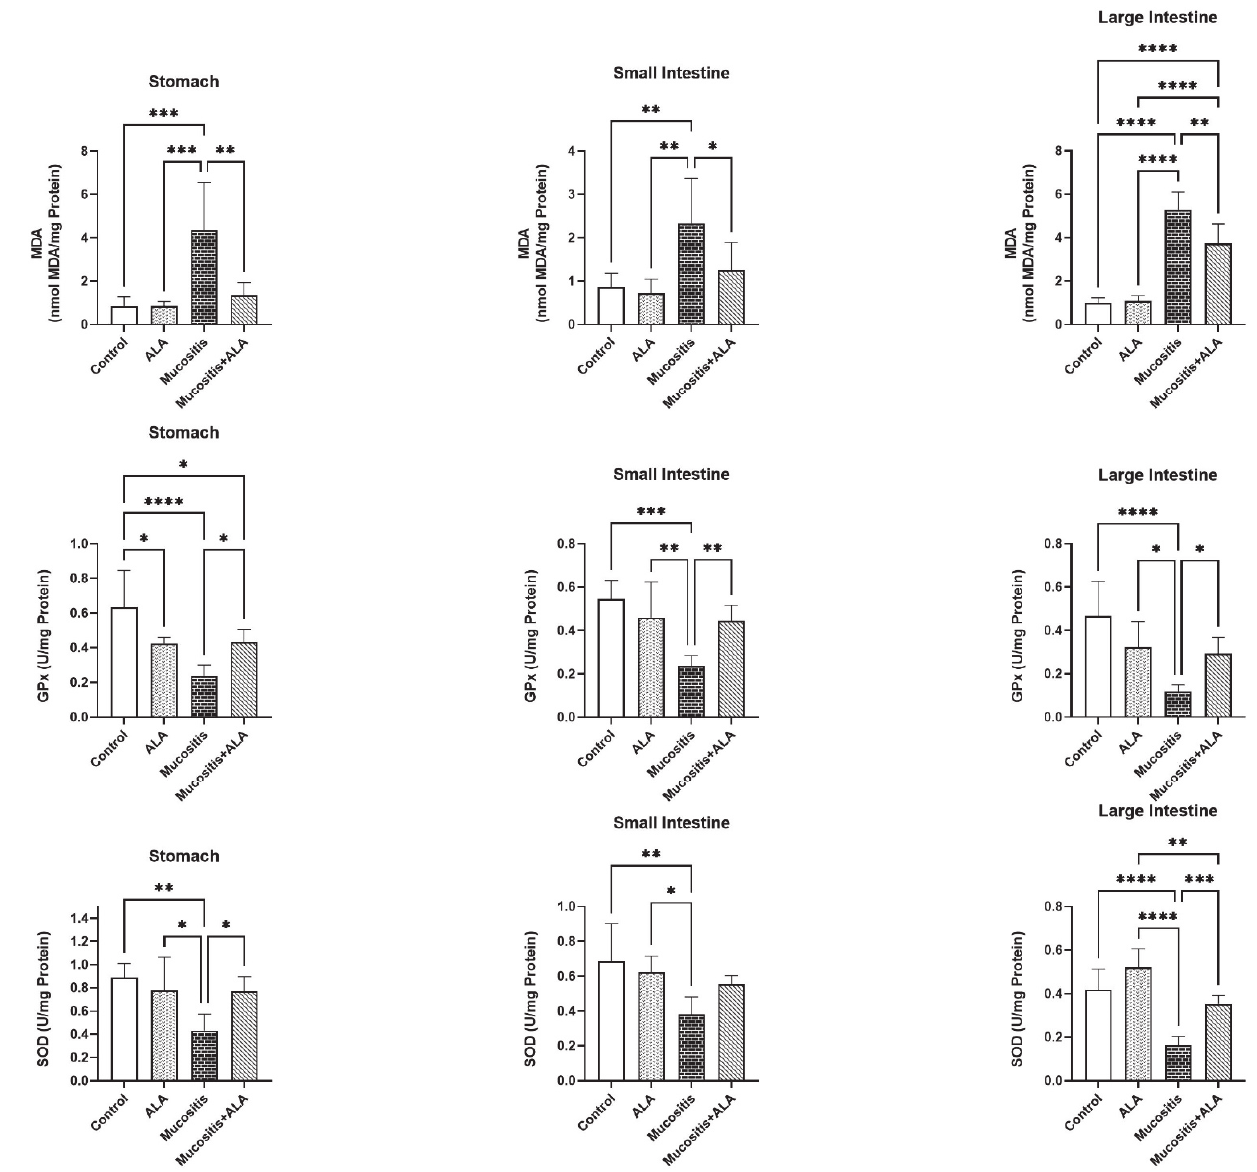
Figure 2. Comparisons of MDA levels and GPx and SOD activities in the stomach, small intestine, and large intestine in the Control, ALA, Mucositis and Mucositis + ALA groups. * p < 0.05, ** p < 0.01, and *** p < 0.001 and **** p < 0.0001. In Mucositis group rats, GPx levels in all tissues were significantly reduced compared to the Control, ALA and Mucositis + ALA groups ( p < 0.05–0.0001). Also, in the stomach tissue, the GPx levels of animals in the ALA and Mucositis + ALA groups were shown to be significantly different to the Control group ( p < 0.05).